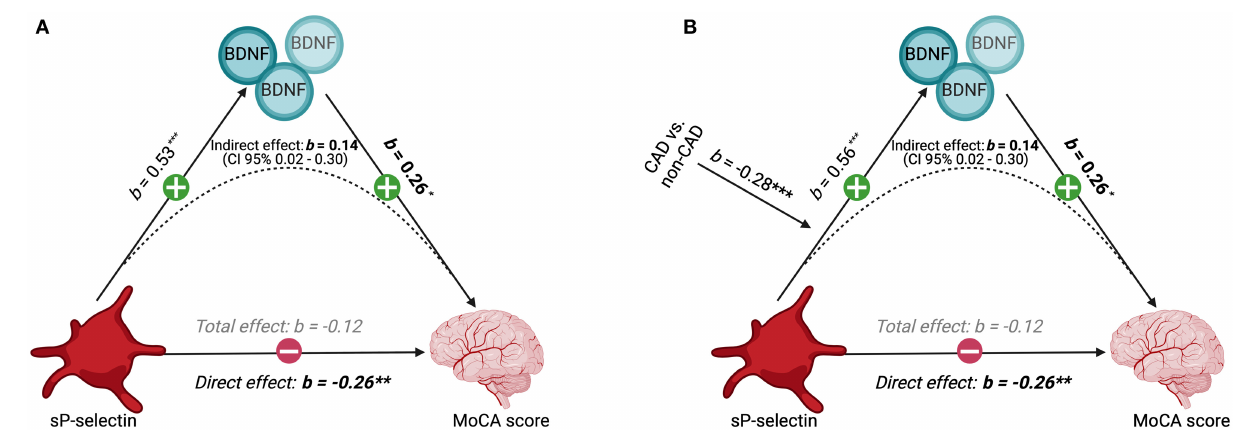
FIGURE 3 | Interplay between platelet activity, BDNF levels, CAD status, and cognitive performance. (A) Mediation model between sP-selectin (independent variable), plasma BDNF concentrations (mediator), and the MoCA score (dependent variable) in the overall population ( n = 1,280), (B) moderated by CAD status, showing unstandardized coefficients. sP-selectin and BDNF concentrations were log-transformed to account for a skewed